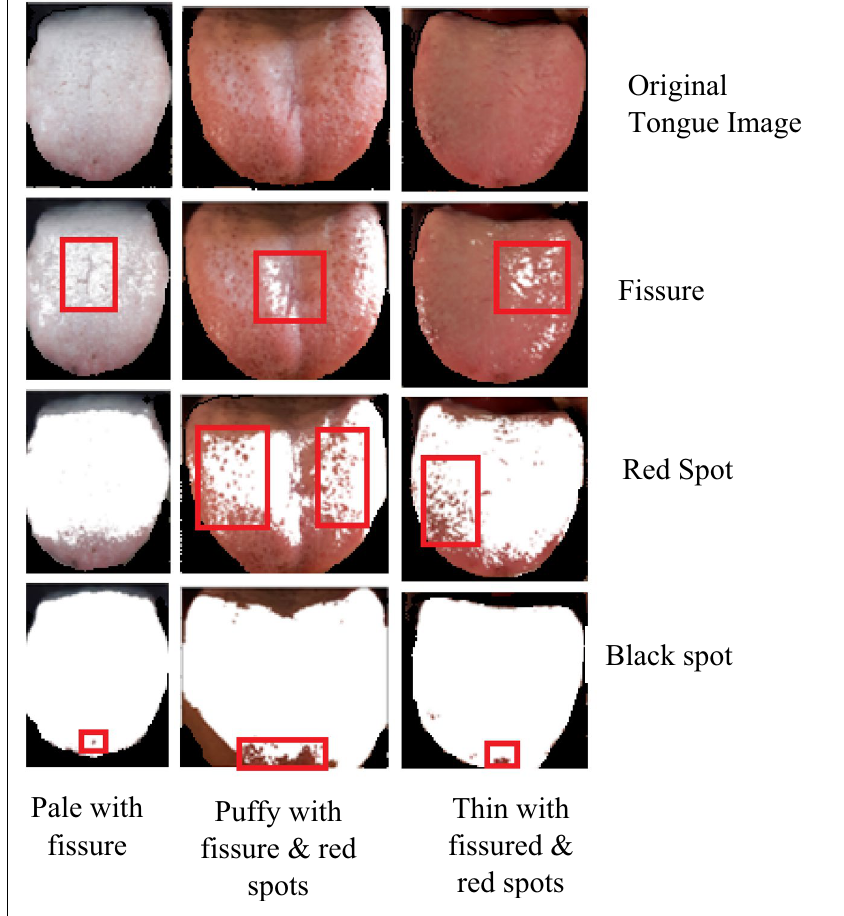
Figure 5. Extracted features of tongue image